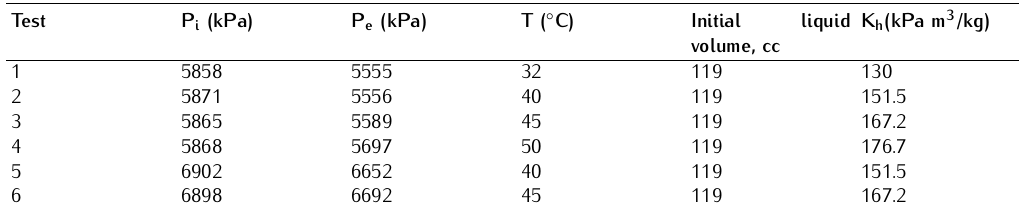
Table 4. Ion analysis of aquifer used in this